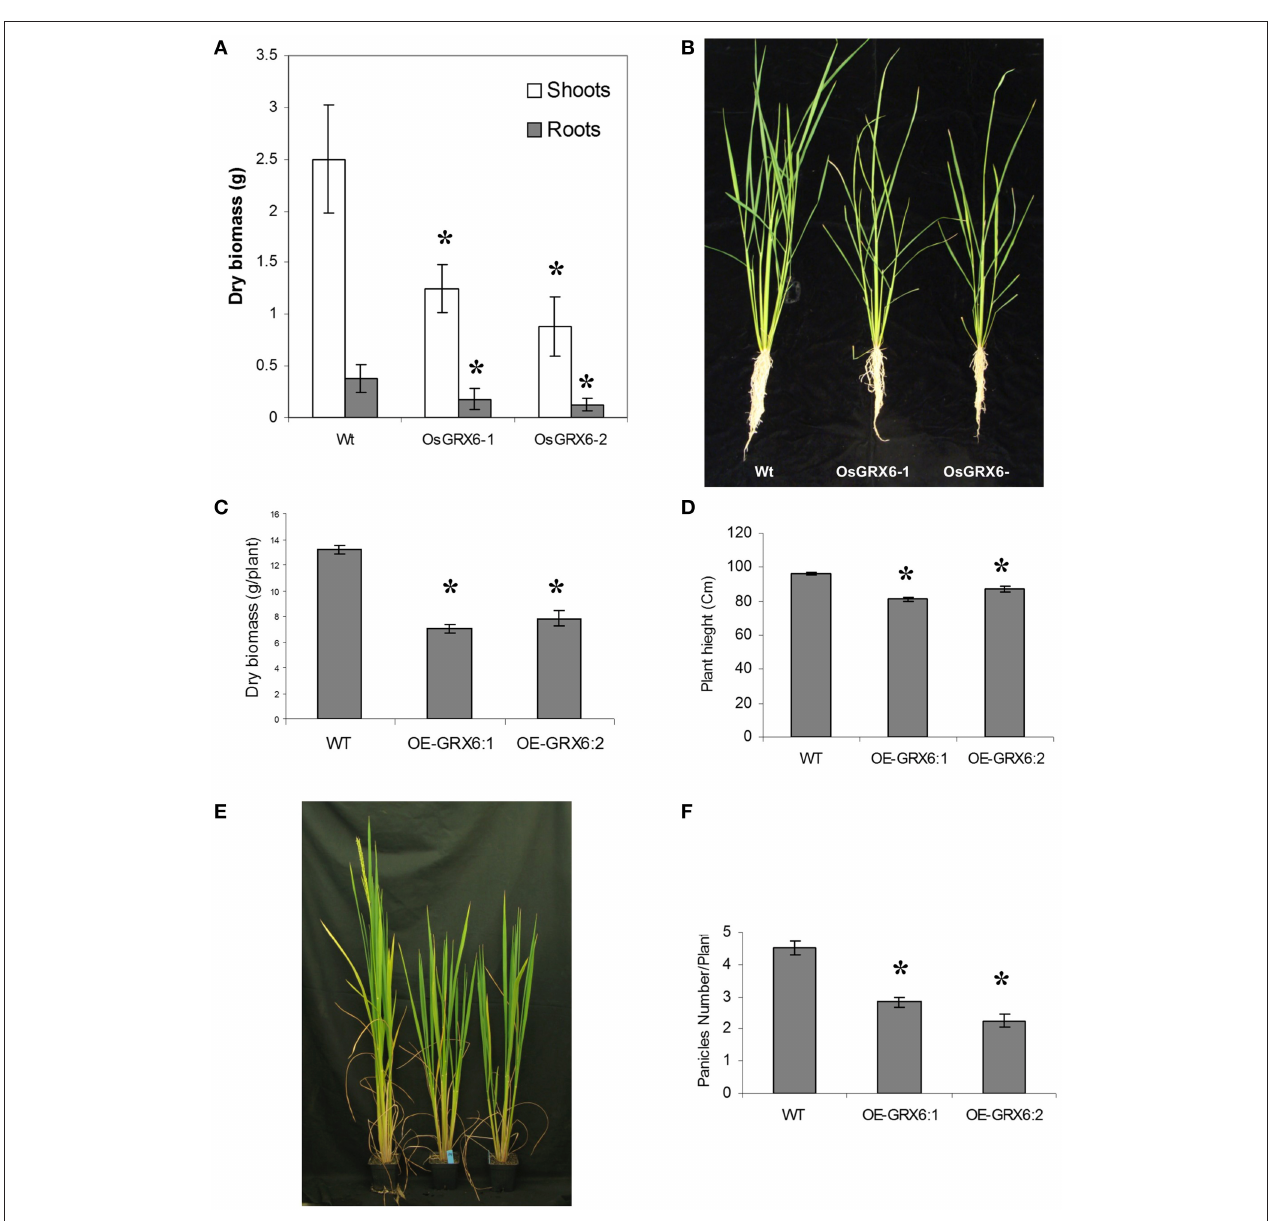
FIGURE 2 | OsGRX6 overexpression alters the rice plant morphology and development. Shoots and roots morphology and dry biomass at 4 weeks (A,B) , at harvest (C,D) , the delaying in flowering time (E) and the lower panicles number in the transgenic plants compared to the wild-type plants (F) . Data are means ± SD of 24 plants, Asterisks indicate significant differences at P ≤